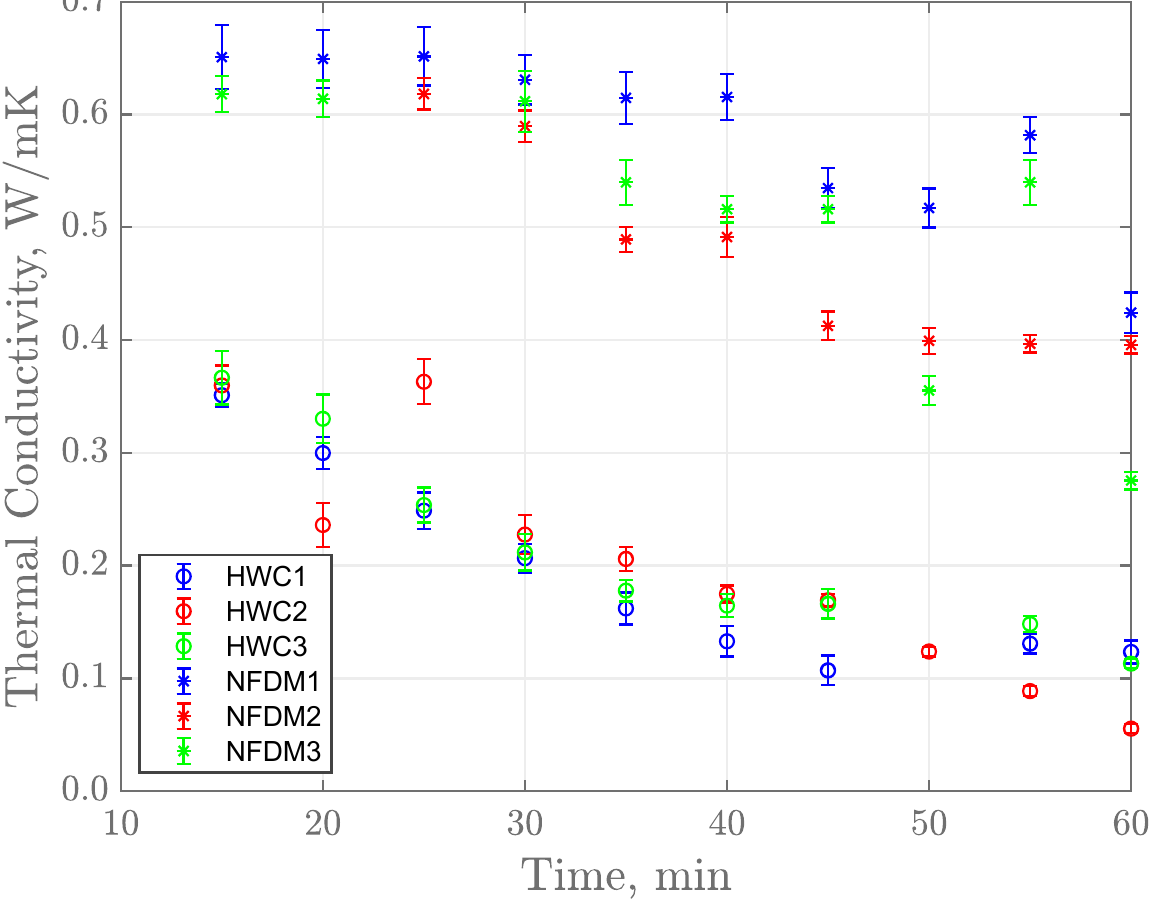
Figure 6. Estimated k average with 95% confidence interval for NFDM and HWC trials.